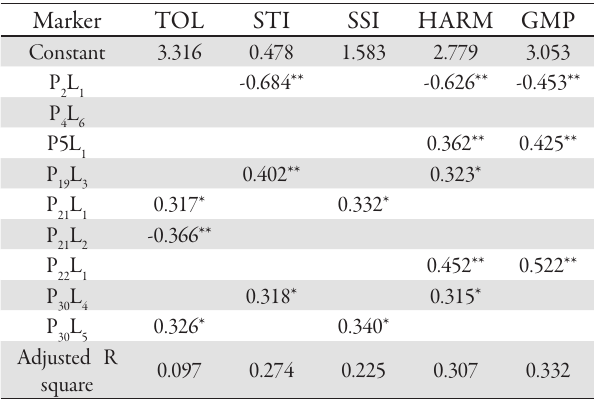
Tab. 7. Regression coefficients between markers and drought tolerance indices in 1/3 continuous